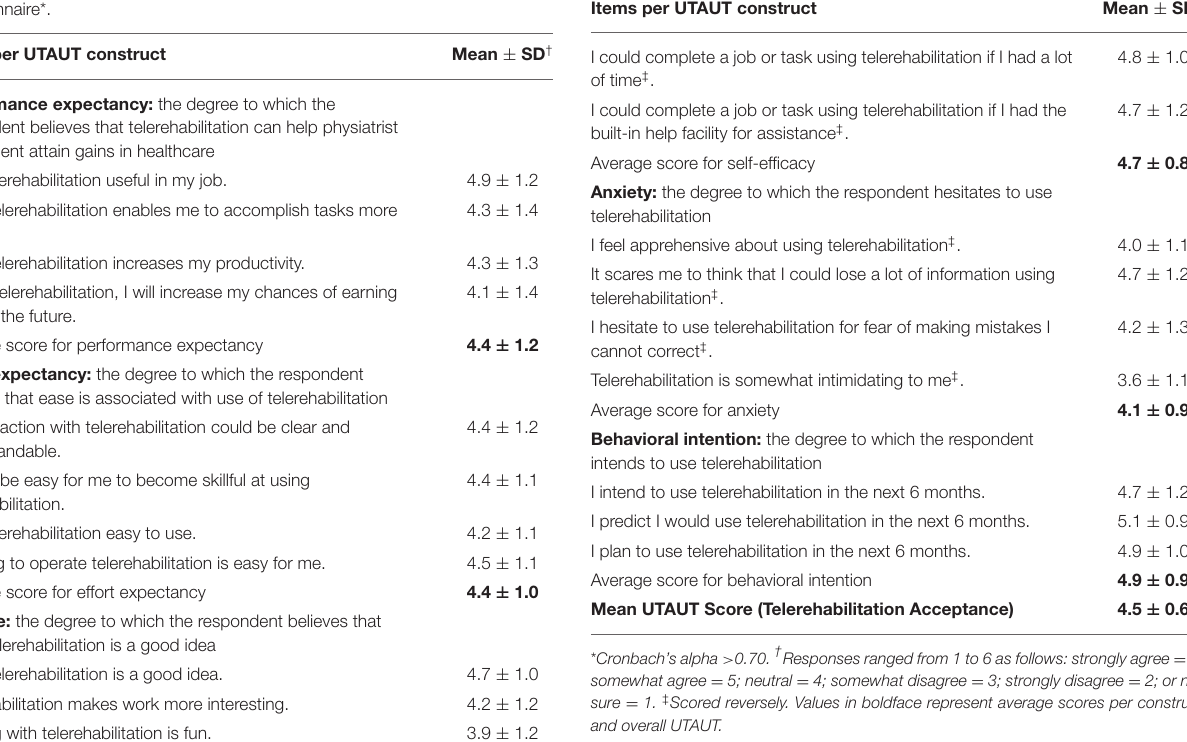
TABLE 4 | Telerehabilitation acceptance of the respondents ( N = 62) based on the modified Unified Theory of Acceptance and Use of Technology (UTAUT)